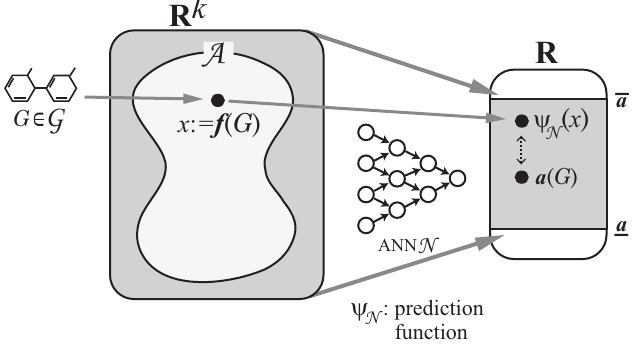
Figure 5. An illustration of Step 3: A prediction function ψ N from the feature vector space R k to the range [ a , a ] is constructed based on an ANN N